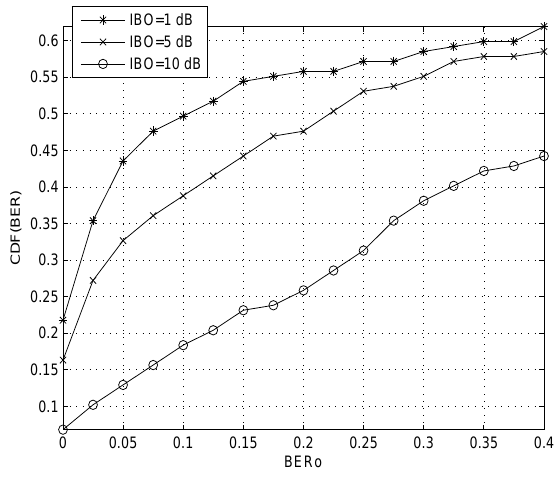
Figure 7. CDF of the BER of received symbols gathered from the SAS-OE HF link. OFDM signals were transmitted at frequencies between 4.4 MHz and 17.6 MHz from 21 UTC to 09 UTC, during the 2006–2007 Antarctic